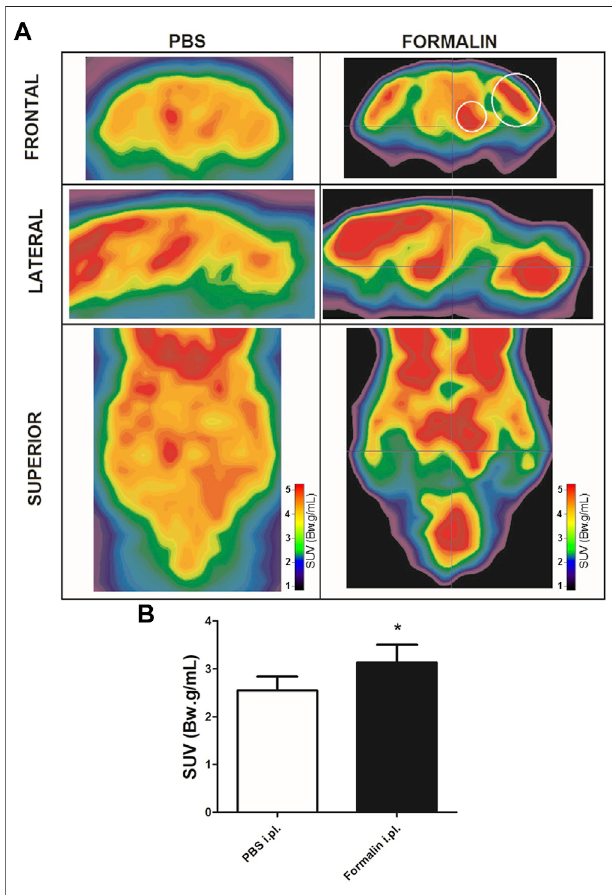
FIGURE 2 | Formalin-induced cerebral metabolic activation. (A) Representative microPET images of brains from rats injected with PBS (left column)or with5% Formalin (right column)into theright hindpaw. Images are presented in different planes, as indicated. Warmer colors indicate higher uptake of 18 F-FDG, hence higher metabolic activity. Small and large white circles depict regions that contains thalamus and somatosensory cortex, respectively. (B) averaged 18 F-FDG uptake of the whole brain in rats that received PBS (white bar, N (cid:1) 4) or 5% Formalin (black bar, N (cid:1) 6) into the right hind paw. Bars represent mean+S.E.M. of the S.U.V. values (* p (cid:1) 0.05, t-student